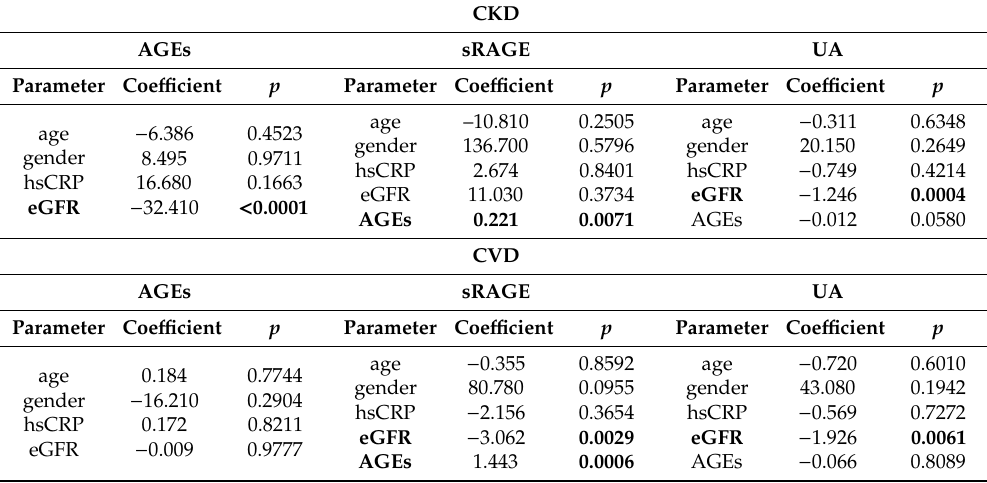
Table 5. Multivariate linear regression analysis of the association between age, gender, hsCRP, and AGEs, sRAGE, UA level in CKD, CVD, and in all the groups studied